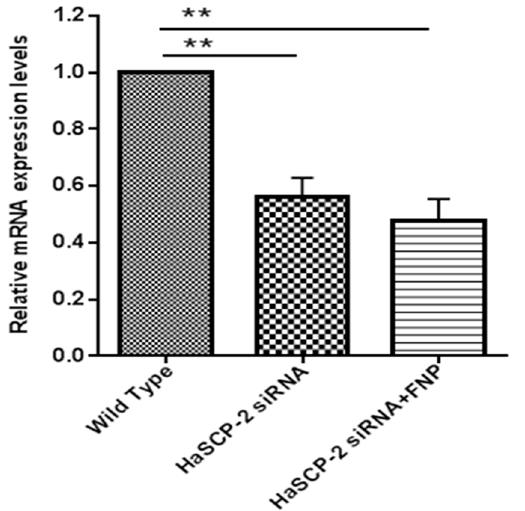
Figure 5. HaSCP-2 mRNA expression level in Ha cells by FNP-RNAi in vitro . Three treatments were set as FNP- HaSCP-2 siRNA-treated group ( HaSCP-2 siRNA + FNP group), HaSCP-2 siRNA group, and wild type (WT; control group). Ha cells were treated with HaSCP-2 siRNA and FNP ( HaSCP-2 siRNA + FNP group). The HaSCP-2 siRNA group was treated with HaSCP-2 siRNA and FuGENE HD transfection reagent. qRT-PCR was performed to examine the HaSCP-2 mRNA expression level in Ha cells at 24 h after FNP- HaSCP-2 siRNA delivery. Data are mean ± SD. Asterisk “**” indicates significance in the gene expression level between the treated and WT groups at p < 0.01 level ( t ‐ test).